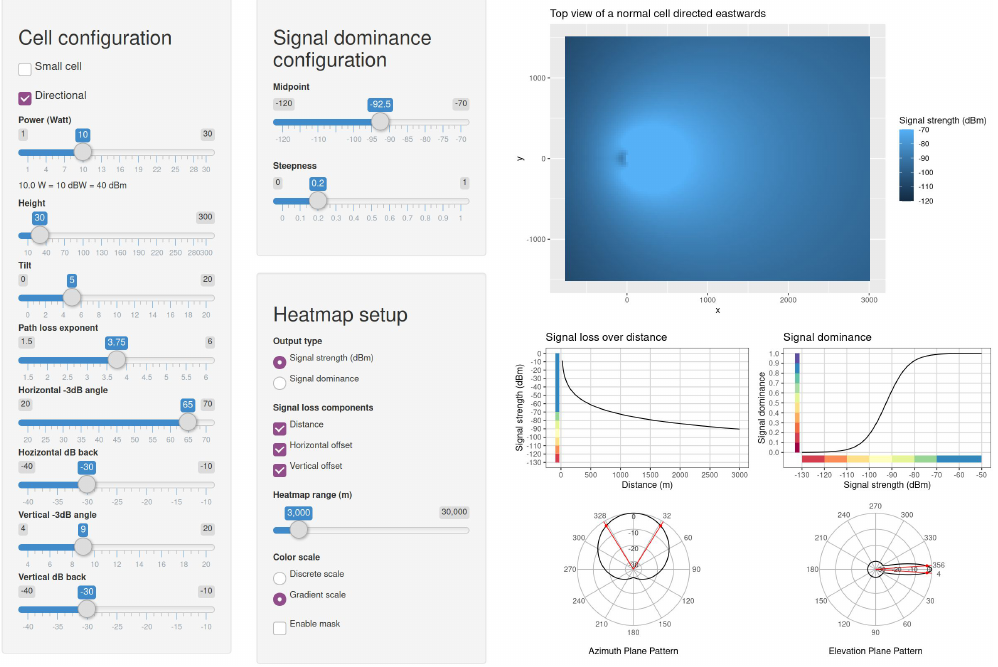
Figure 13: Screenshot of the signal strength model setup